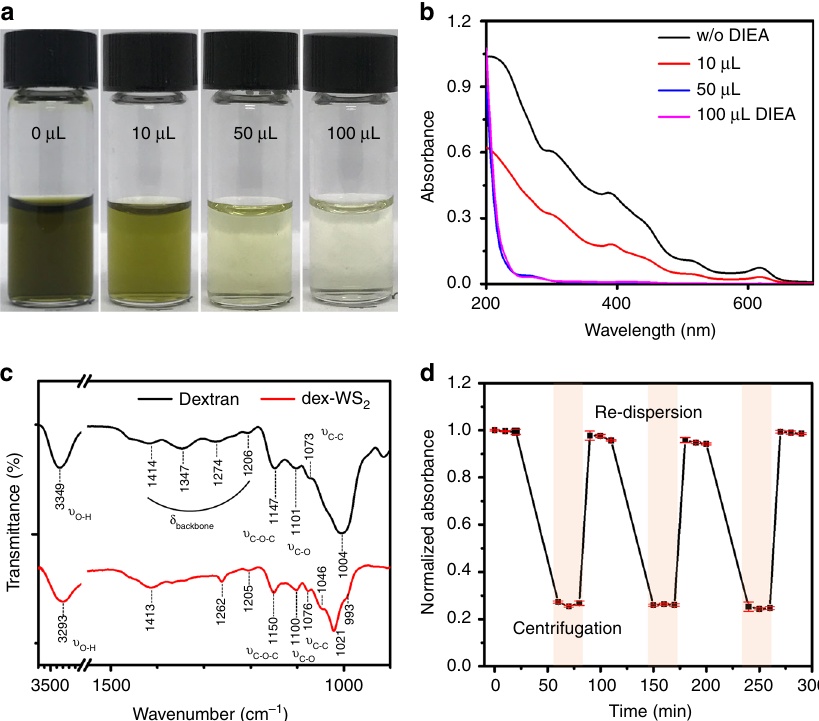
Fig. 3 Multivalent hydrogen bonding in dex-WS 2 nanosheets. a Photographs and b UV – Vis spectra of the solution of WS 2 nanosheets exfoliated and functionalized by dextran in the presence of a proton acceptor DIEA at various concentrations. c FT-IR spectra of dex-WS 2 and dextran, showing hydrogen bonding between WS 2 and dextran. d Absorbance plot of the repeated redispersion of dex-WS 2 after centrifugation, demonstrating that the multivalent hydrogen bonding is suf fi ciently strong to maintain the stability of the dex-WS 2 colloid in repeated centrifugation-redispersion processes. The absorbance was measured at 621 nm. All error bars represent a standard deviation from the mean values ( n =